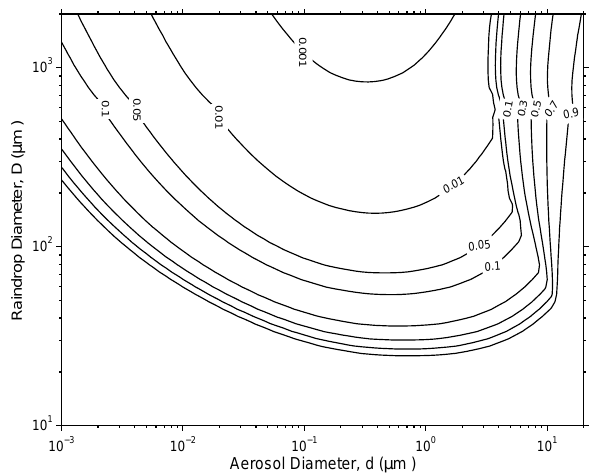
Fig. 3. Scavenging coefficients determined with six different col- lection efficiency parameterizations as a function of particle size for rainfall intensities of 0.1mmh − 1 (dashed line) and 10mmh − 1 (solid